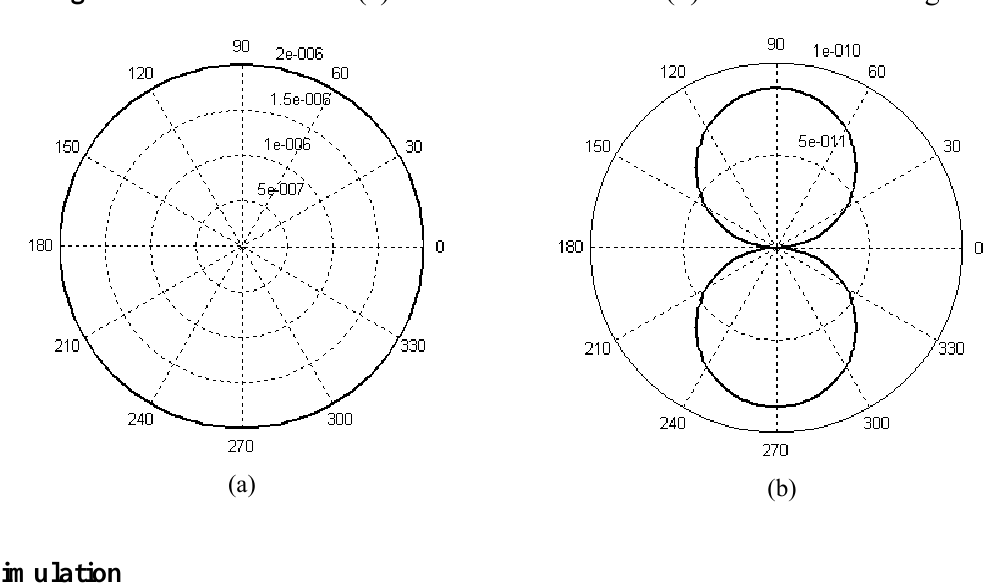
Figure 4. Resultant force (a) and resultant moment (b) versus incident